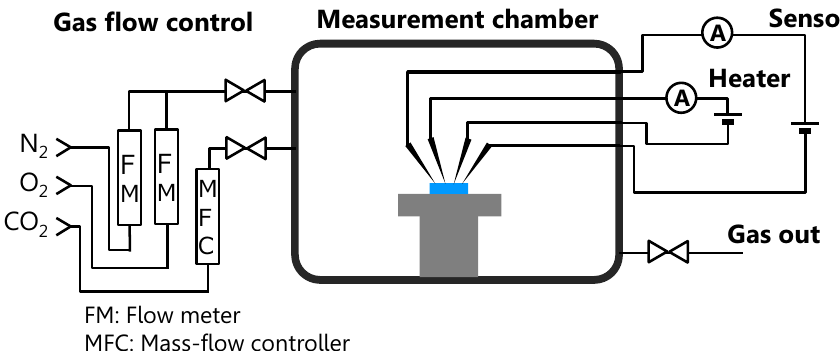
Figure 2. Schematic illustration of the measurement system. Three gas lines (N 2 , O 2 , and CO 2 ) are equipped with the system, and these gases are introduced into the chamber through flow meters and a mass–flow controller.